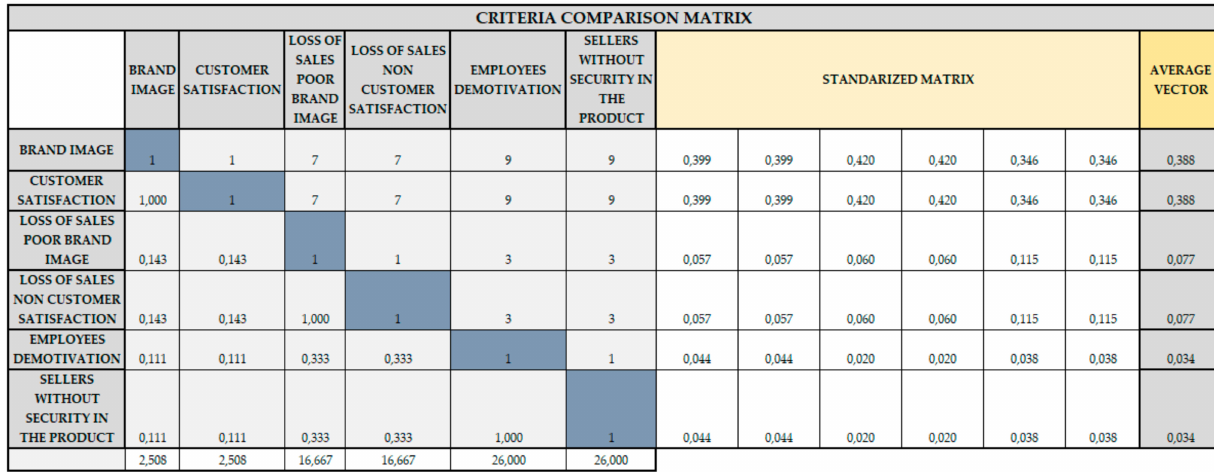
Figure 3. Example of criteria comparison matrix.